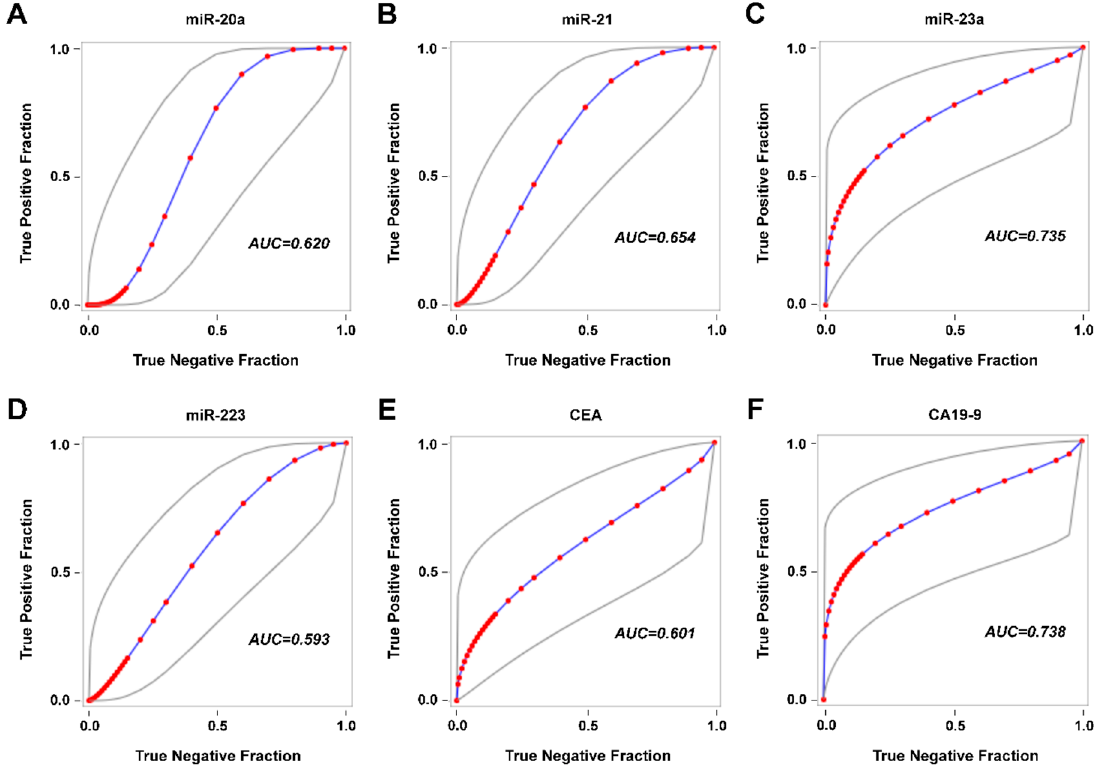
Figure 6. Receiver operating characteristic (ROC) curves for miR-20a ( A ), miR-21 ( B ), miR-23a ( C ), miR-223 ( D ), CEA ( E ), and CA19-9 ( F ). Abbreviations: AUC—area under the curve.